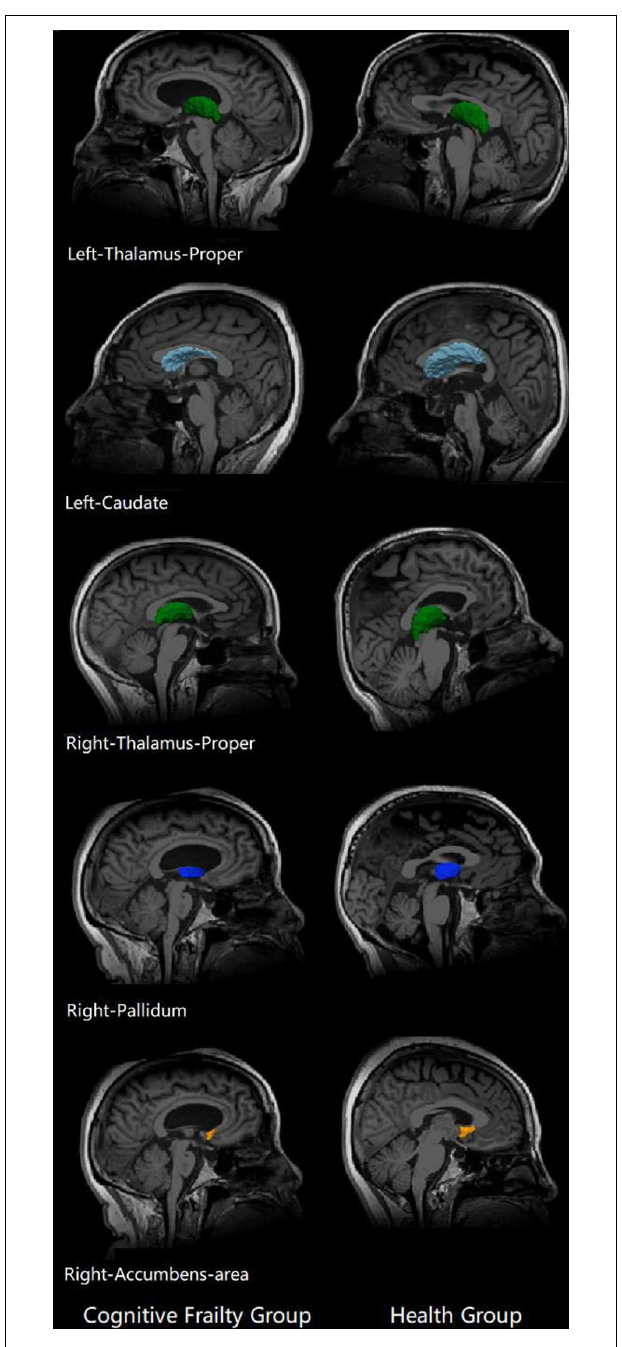
FIGURE 2 | Subcortical nuclei with differences in the two groups. Brain structural changes associated cognitive frailty. Cognitive frailty group showed a decrease in the volume of subcortical nucleus compared with health